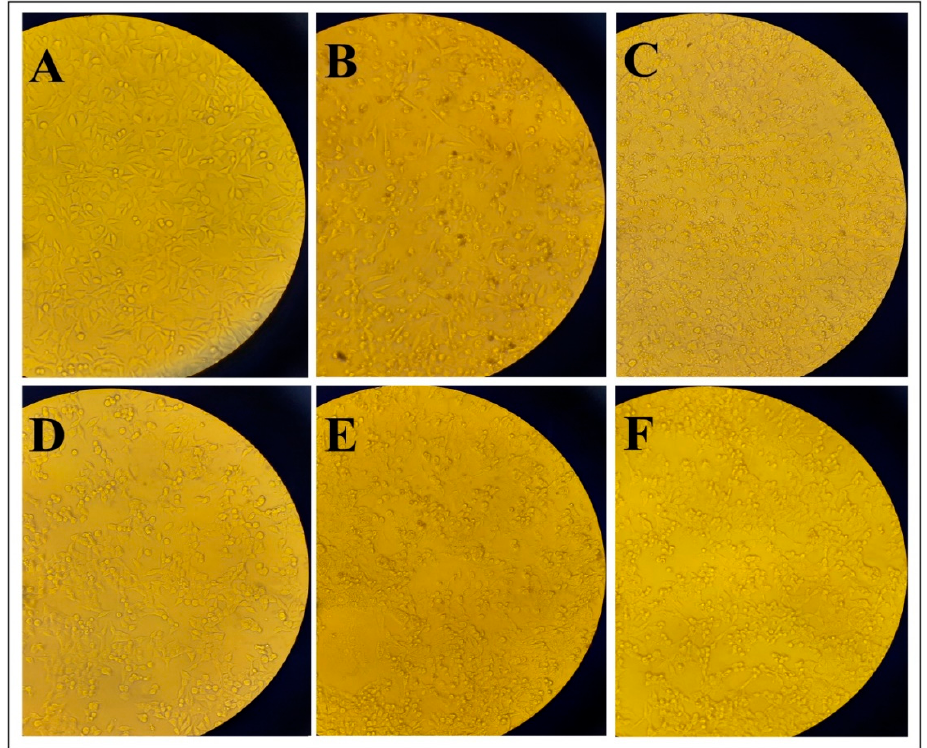
Figure 7. Optical microscopy images of cells treated with NPs for 48 h. ( A ) untreated Michigan Cancer Foundation-7 (MCF7) cells; ( B ) MCF7 cells treated with 100 µ g/mL of CoNiZn NPs; ( C ) MCF7 cells treated with 100 µg/mL of CoNiFe NPs; ( D ) untreated human umbilical vascular endothelial cells (HUVECs); ( E ) HUVEC cells treated with 100 µg/mL of CoNiZn NPs; ( F ) HUVEC cells treated with 100 µg/mL of CoNiFe NPs.